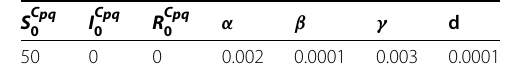
Table 1 Parameter values of α , β , γ and d associated with a cell C pq , p , q = 1,..., M , utilized for the resolution of all multi-regions discrete-time systems (1)-(3) and (4)-(6), and then leading to simulations obtained from Figure 2 to Figure 19, with the initial conditions S C pq and R C pq associated with any cell C pq of (cid:5) I C pq 0 0 α β γ d S Cpq I Cpq R Cpq 0 0 0 50